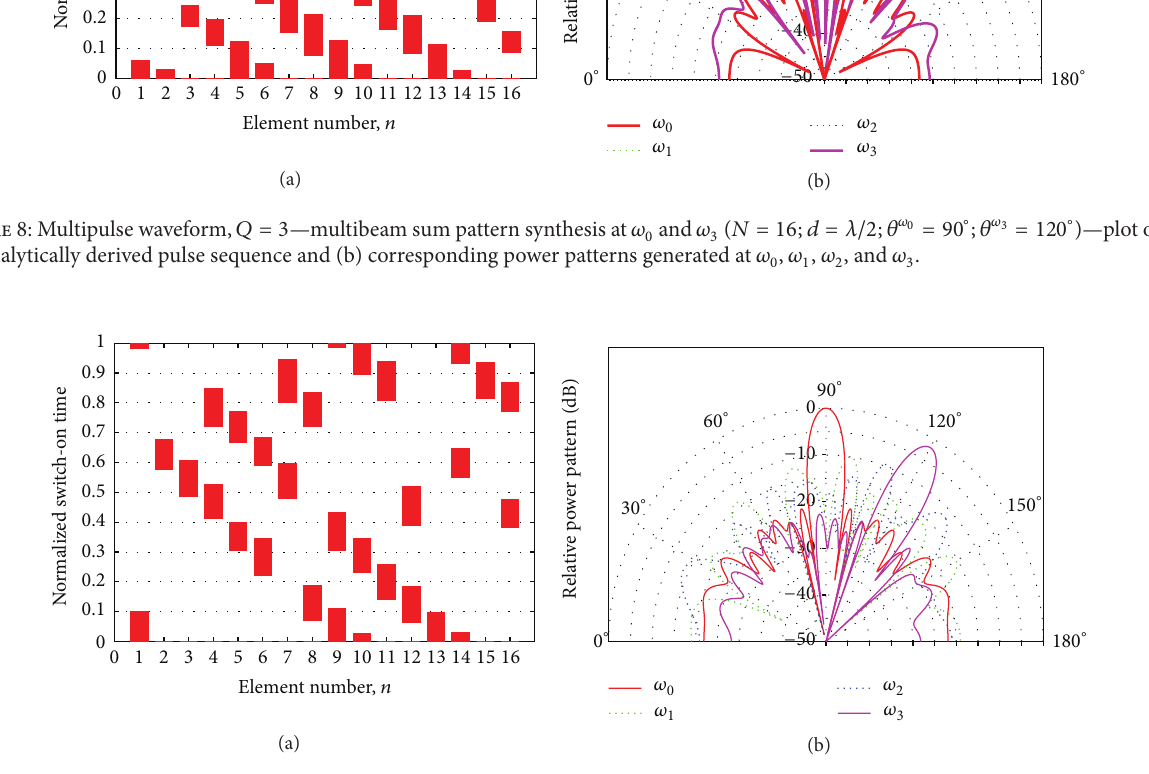
Figure 9: Multipulse waveform, 𝑄 = 2 —multibeam sum pattern synthesis at 𝜔 0 and 𝜔 3 ( 𝑁 = 16 ; 𝑑 = 𝜆/2 ; 𝜃 𝜔 0 = 90 ∘ ; 𝜃 𝜔 3 = 120 ∘ )—plot of (a) the optimized pulse sequence and (b) corresponding power patterns generated at 𝜔 0 , 𝜔 1 , 𝜔 2 , and 𝜔 3